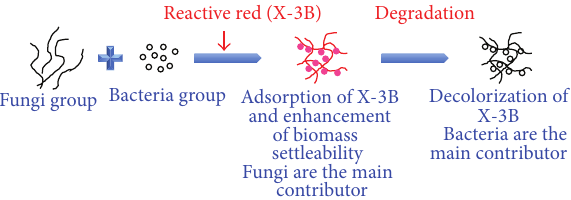
Figure 4: Insight into the synergistic effect of fungi and bacteria for reactive red X-3B